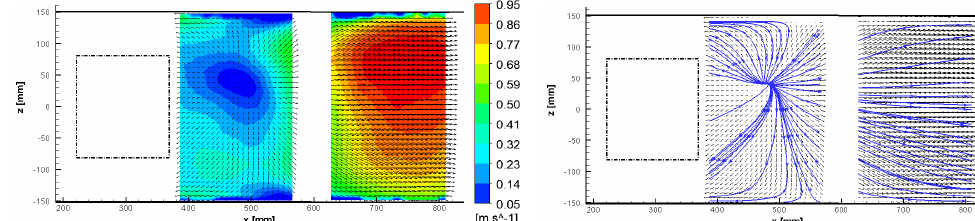
Figure 24. PIV measurements, the magnitude of time-averaged 2D velocity (left panel) and vector lines in horizontal plane ( y = 10mm )